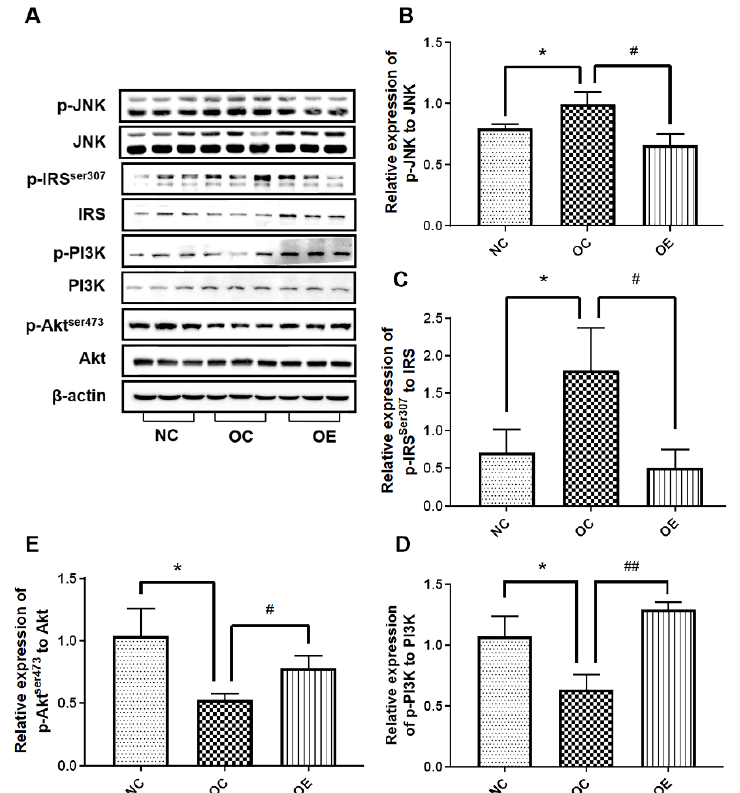
Figure 5. The Western blot of proteins associated with insulin signal pathway ( A ) and corre- sponding statistical analysis of p-JNK/JNK ( B ), p-IRS-1 ser307 /IRS-1 ( C ), p-PI3K p85/PI3K ( D ), and p-Akt ser473 /Akt ( E ) ratios in the hippocampal tissues. All data were presented as mean ± standard deviation (M ± SD) ( n = 3 mice per group). Compared with the NC group, * p < 0.05; compared with the OE group, # p < 0.05, ## p < 0.01.